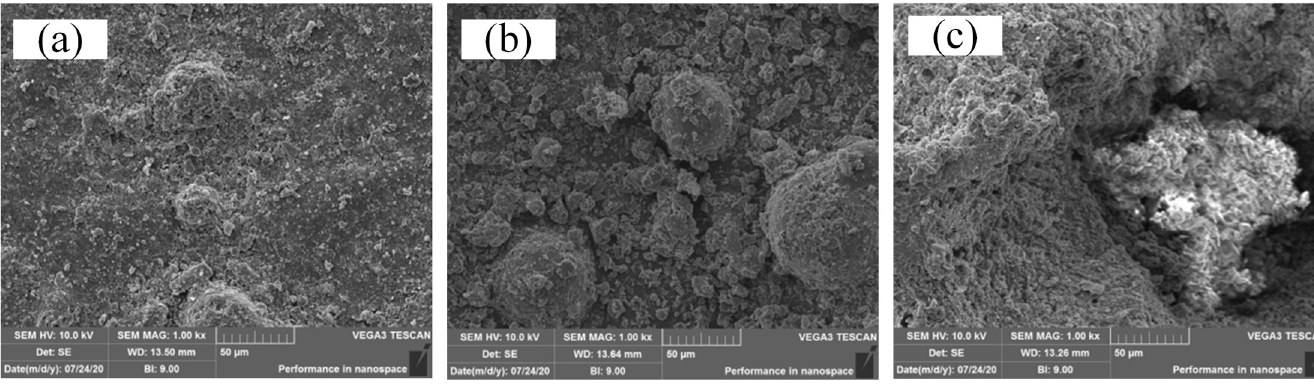
PLOS ONE | https://doi.org/10.1371/journal.pone.0251092 June 4,